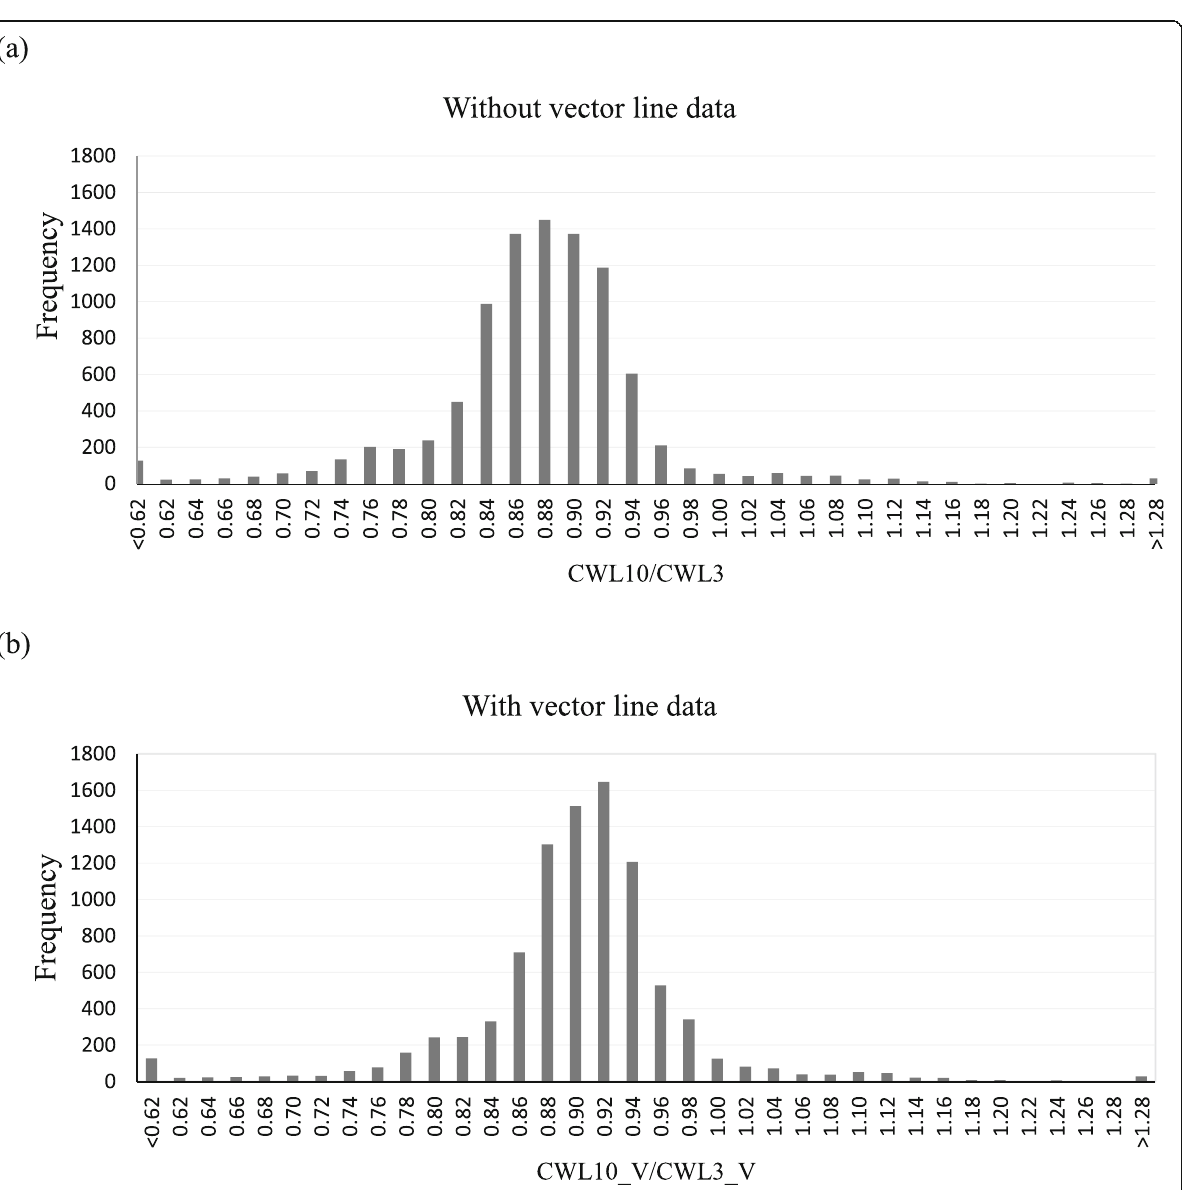
Fig. 7 Frequency distribution of 9203 sample values of a CWL10/CWL3 and b CWL10_V/CWL3_V